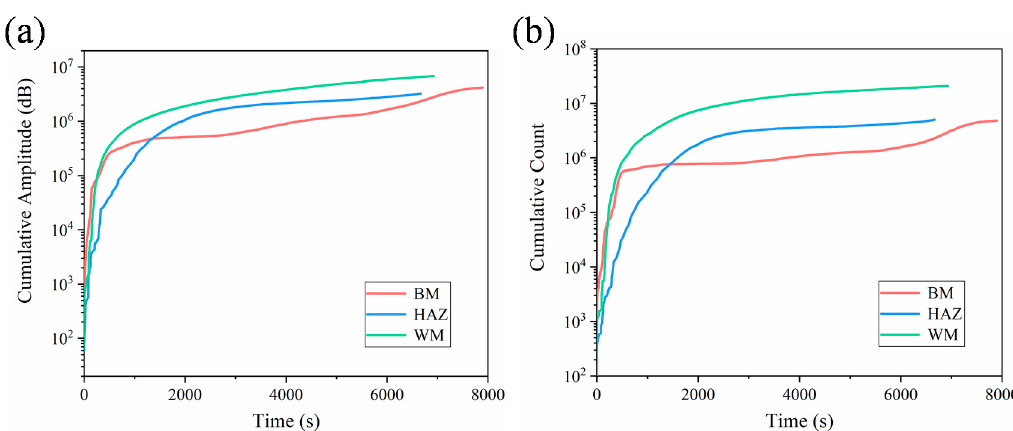
Figure 11. ( a ) The cumulative amplitude and ( b ) cumulative count with respect to fatigue loading time for different spec- imens.